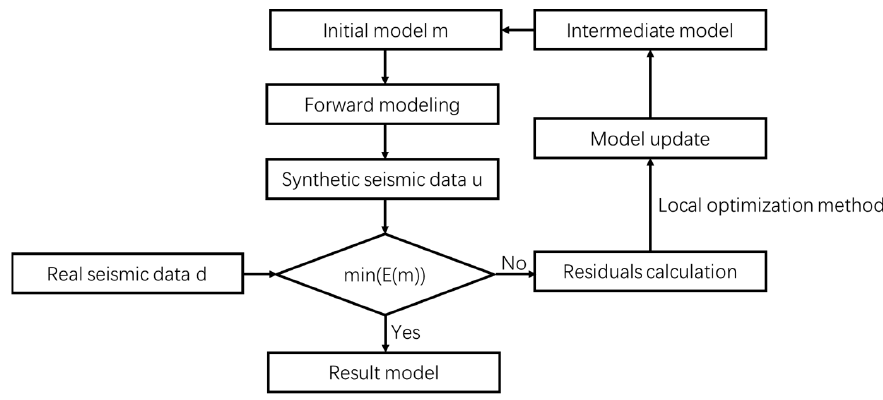
Figure 3. The conventional FWI workflow.